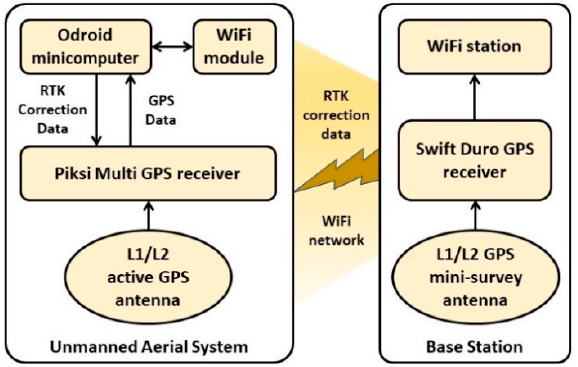
Figure 2. Real time kinematic (RTK) GPS operation diagram.